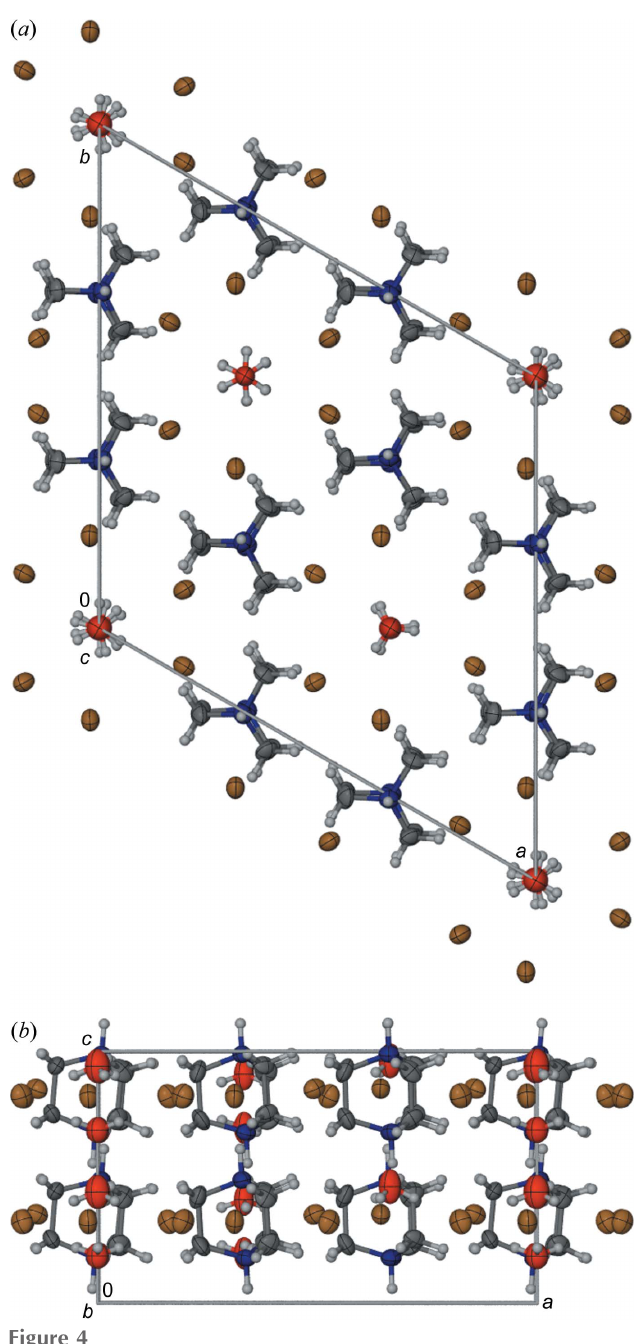
Figure 4 Crystal structure of polymorph (cid:3) -[dabcoH 2 ] 2+ [H 3 O] + Br (cid:2) 3 projected along ( a ) the [001] direction and ( b ) the [010] direction. Partially occupied sites of the disordered hydronium cations are indicated. Colour code: brown Br; blue N, red O; dark grey C; light grey